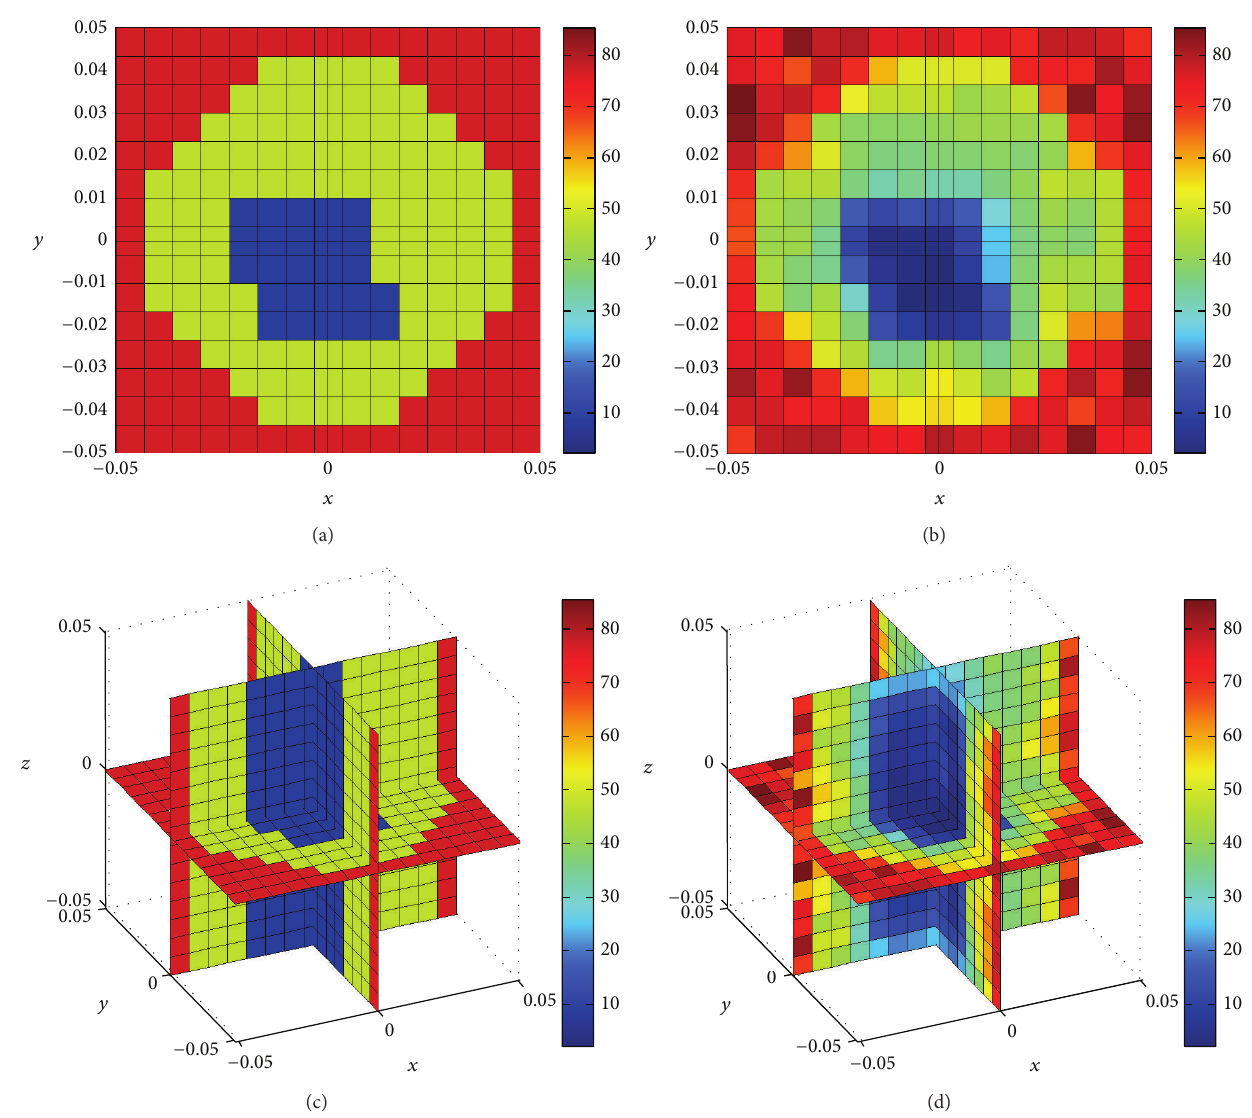
Figure 5: Real part of the exact permittivity used to simulate the data at 1GHz with a SNR of 30 dB (left) and of the reconstructed permittivity (right) for the adult’s arm phantom, in the 𝑥𝑦 -plane (top) and in three perpendicular planes (bottom). Distances are in m.